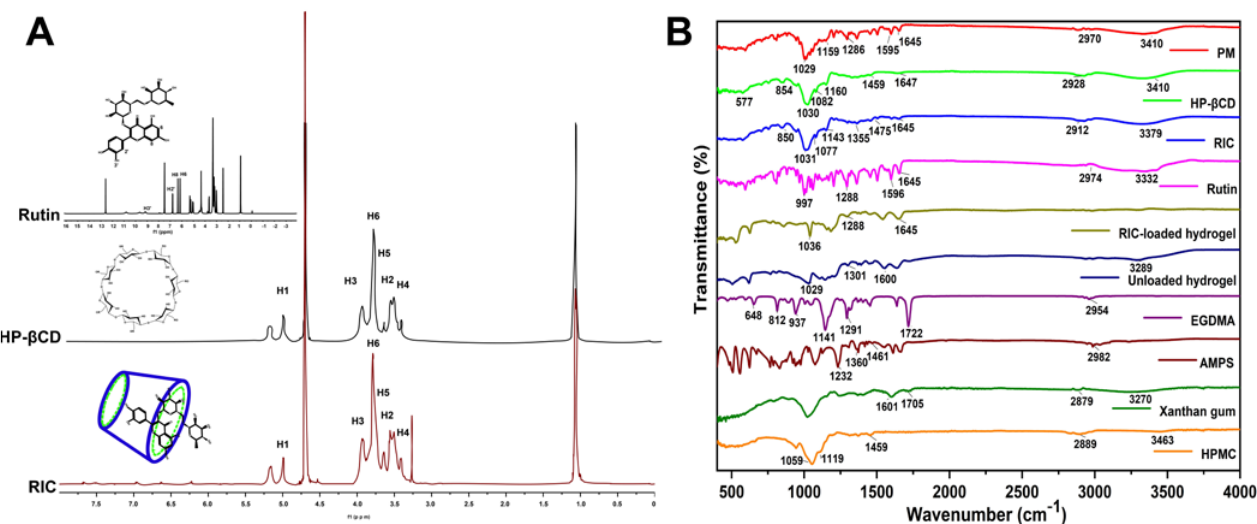
Figure 2. 1 H NMR of the rutin inclusion complexes ( A ) and FTIR analysis of the pure components and developed hydrogels ( B ).